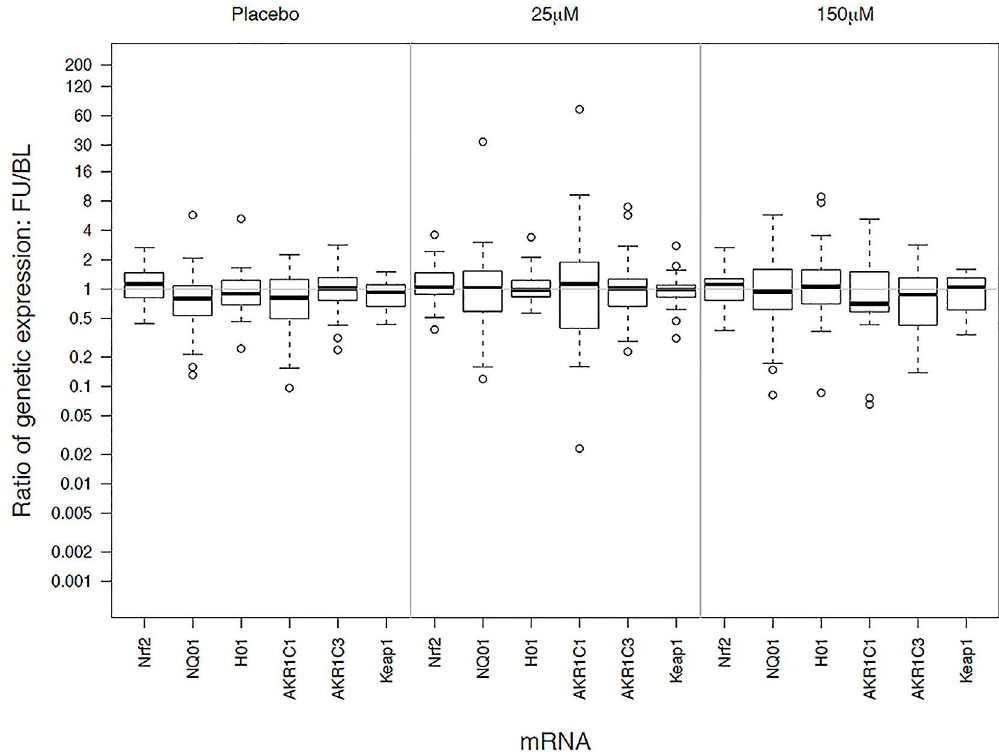
Fig 2. Relative changes in gene expression by treatment group in alveolar macrophages Treatments are labeled as placebo (no sulforaphane), 25 μ M) and 150 μ M of sulforaphane. Gene identifiersare listed along the x-axis. The y-axis displaysthe distribution of fold-change in gene expression(follow-updividedby baseline).